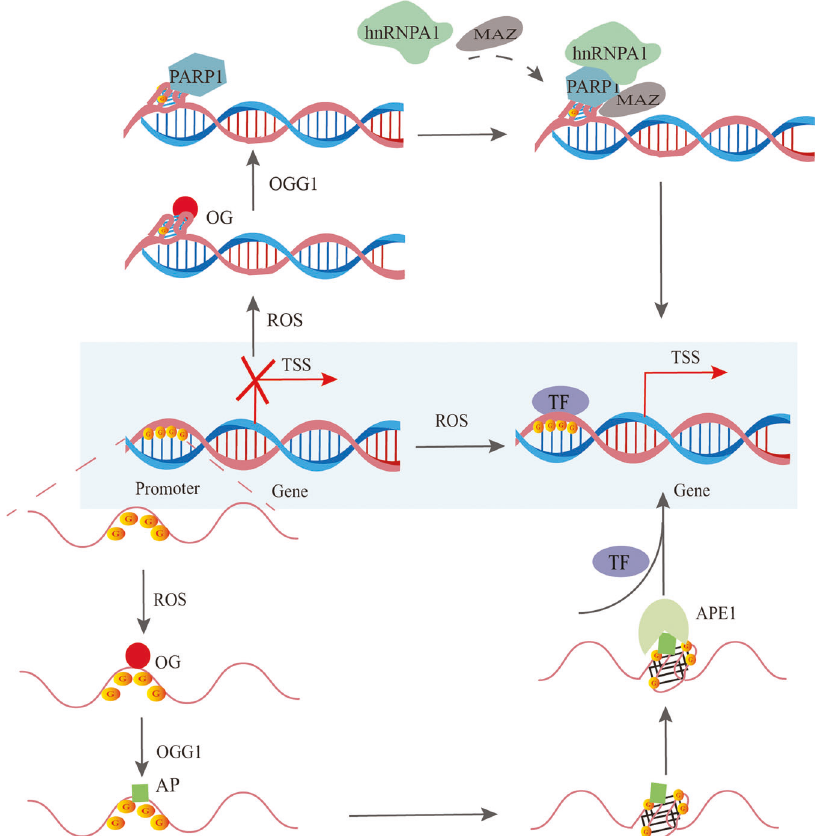
Fig. 5 The possible mechanisms of ROS-regulated gene transcription depending on promoter G4s. Under oxidative stress, ROS can lead to OG formation in the G-rich region of promoters, which recruits OGG1 to clear OG and form the AP site. APE1 then binds to AP when looped out in the G4 fold to recruit TFs. On the other hand, ROS can also directly attack the G4 structure of the promoter region and form OG, which facilitates the recruitment of PARP1 and the binding of other transcriptional activating proteins to promote gene